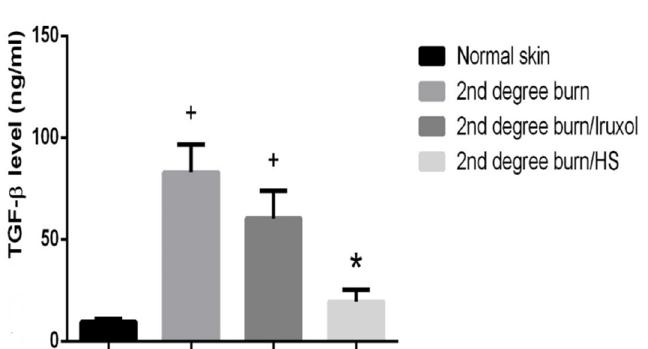
Figure 7. Effect of HS on transforming growth factor β (TGF-β) level. TGF-β: transforming growth factor-beta; HS: Hibiscus sabdariffa; +, ( p < 0.05) vs. normal group; *, ( p < 0.05) vs. 2nd degree burn group. Differences between groups were examined by ANOVA/Tukey/Kramer’s multiple compar- ison test. n = 6.